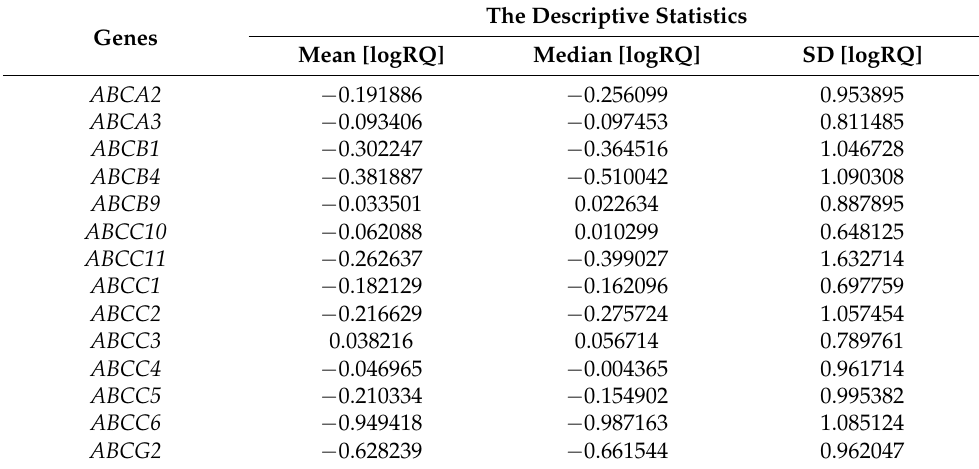
Table 1. The expression levels of selected genes from the ABC family—descriptive statistics. The Descriptive Statistics Genes Mean [logRQ] Median [logRQ] SD